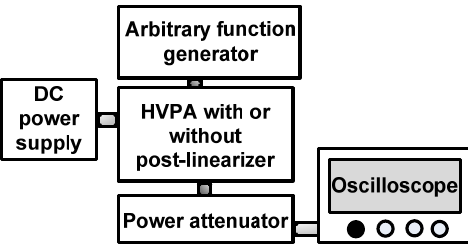
Figure 5. Measurement setup to calculate the gain as a function of HVPA input power and frequency with and without the post ‐ linearizer.